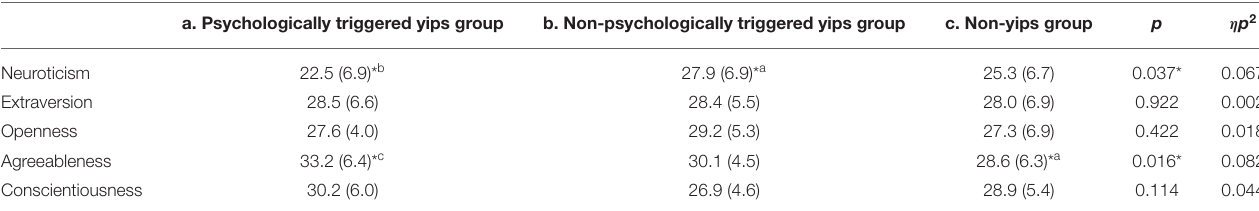
TABLE 5 | Results of the